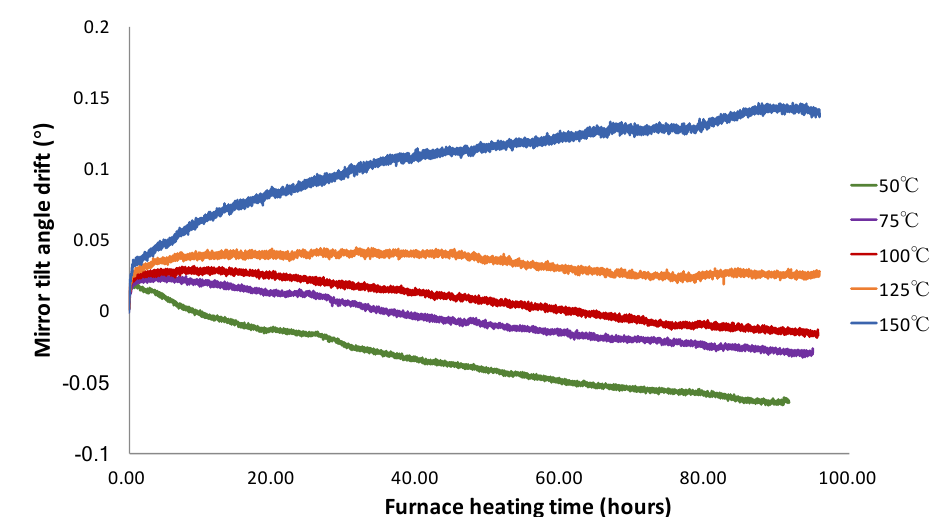
Figure 5. Mirror tilt angle drift as a function of time at different furnace temperatures.